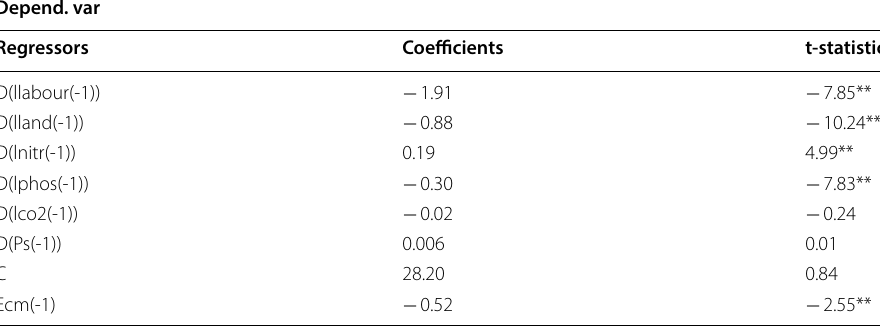
Table 5 Error correction model Source : Author’s calculation Depend. var